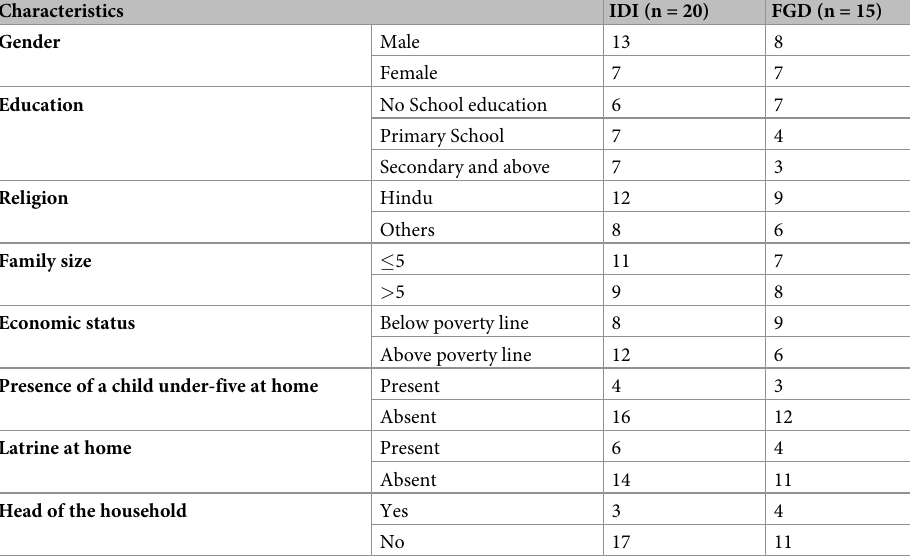
Table 1. Socio-demographic characteristics of the respondents.